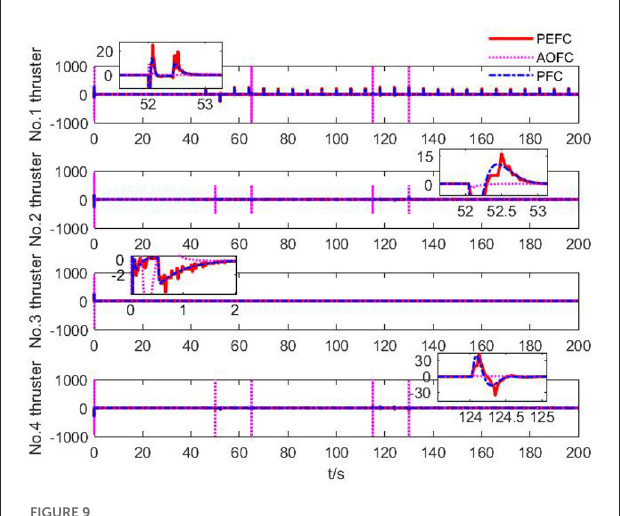
FIGURE8 Fault adaptive curve of thruster.